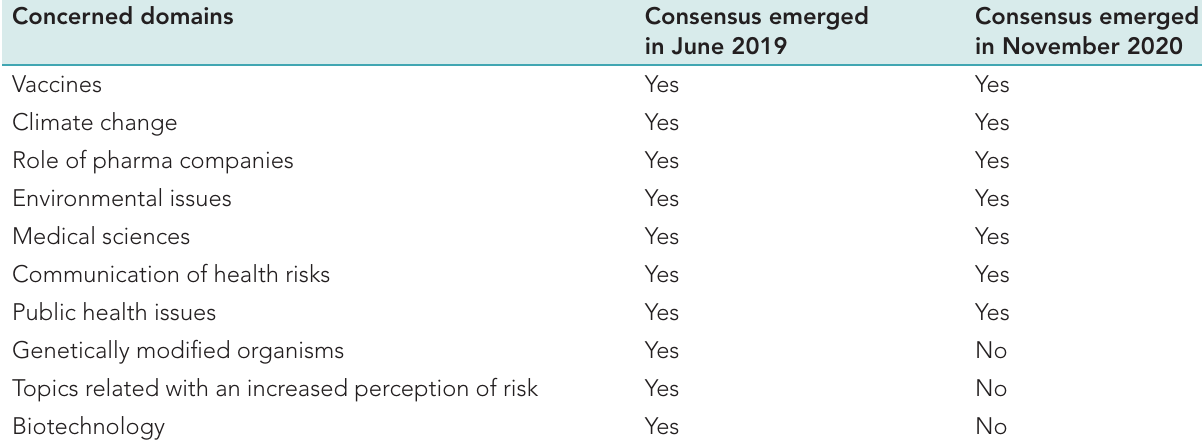
Table 4. Domains in which trust in scicomm is perceived as critical by the Delphi panel (Source: Authors, 2022)